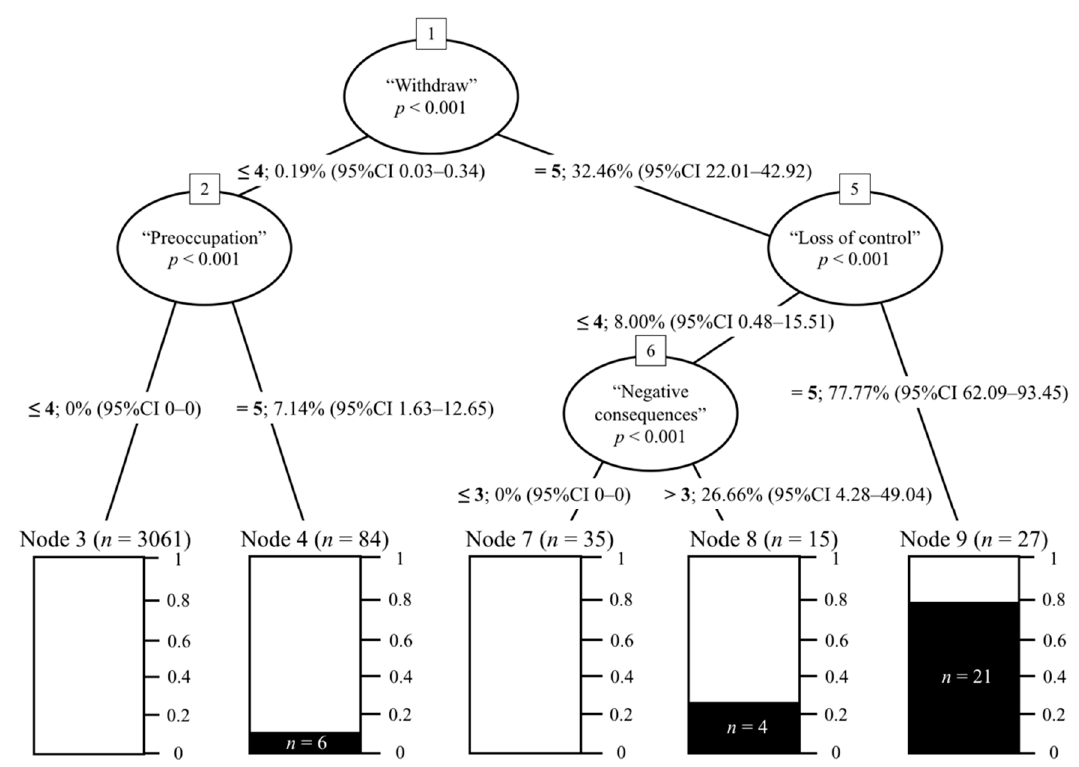
Figure 2. Summary of the Conditional Inference Tree (Ctree) analysis on the nine Internet Gaming Disorder (IGD) criteria across the whole sample ( N = 3222) and disordered gamers ( n = 31).